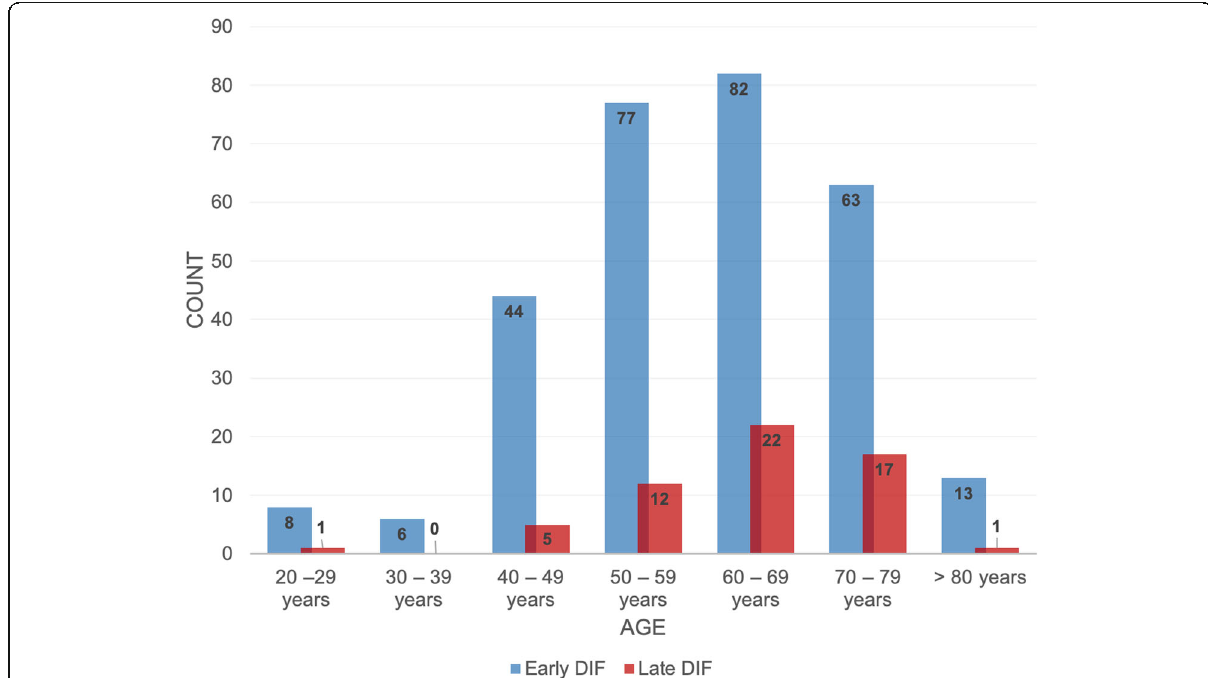
Fig. 2 Frequency of early and late dental implant failure (DIF) among patients of different